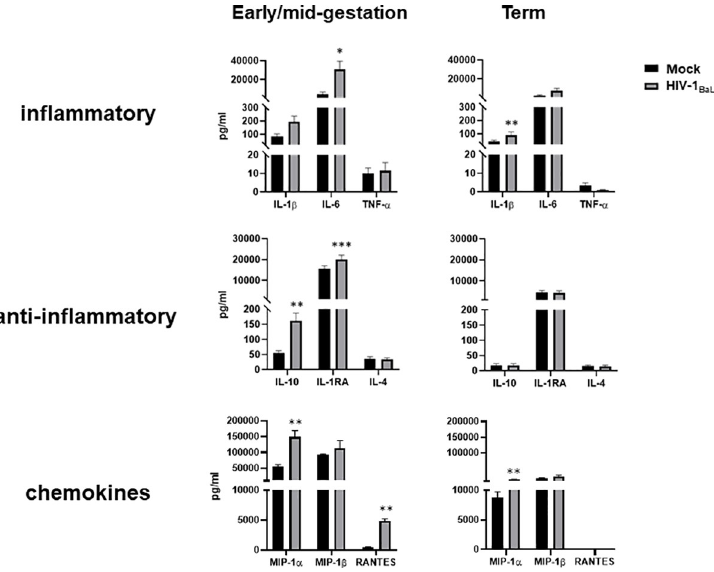
Fig 4. HIV Infection of Early/Mid-Gestation HCs Induces the Secretion of IL-6 and IL-10. A , Hofbauer cells (isolated from early/mid-gestation and term) were infected with HIV-1BaL (black bars) or mock-infected (gray bars). Quantification of inflammatory cytokine, anti-inflammatory cytokine, and chemokine protein levels were determined in the supernatants by Luminex following 48 hours of in vitro culture. All values are represented as pg/mL. Data shown are expressed as the mean ± standard error of biological triplicates from 10 individual donors analyzed by paired t-test analysis using the two-stage linear step-up procedure of Benjamini, Krieger and Yekutieli. ��� p < 0.0001, �� p < .001, and � p < .05 indicate significance between HIV-infected HCs and mock-infected